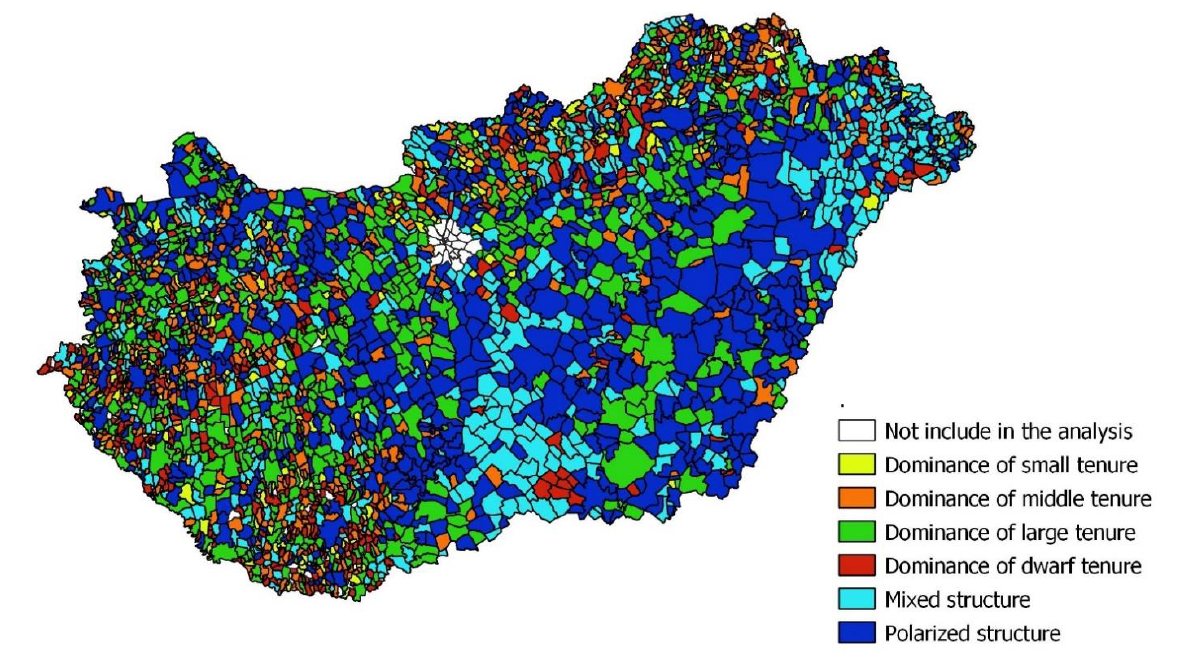
Figure 2. Settlements in Hungary based on the land use structure (result of latent profile analysis). Table 3. Composition of the settlement groups in the land use structure according to legal status. Settlement